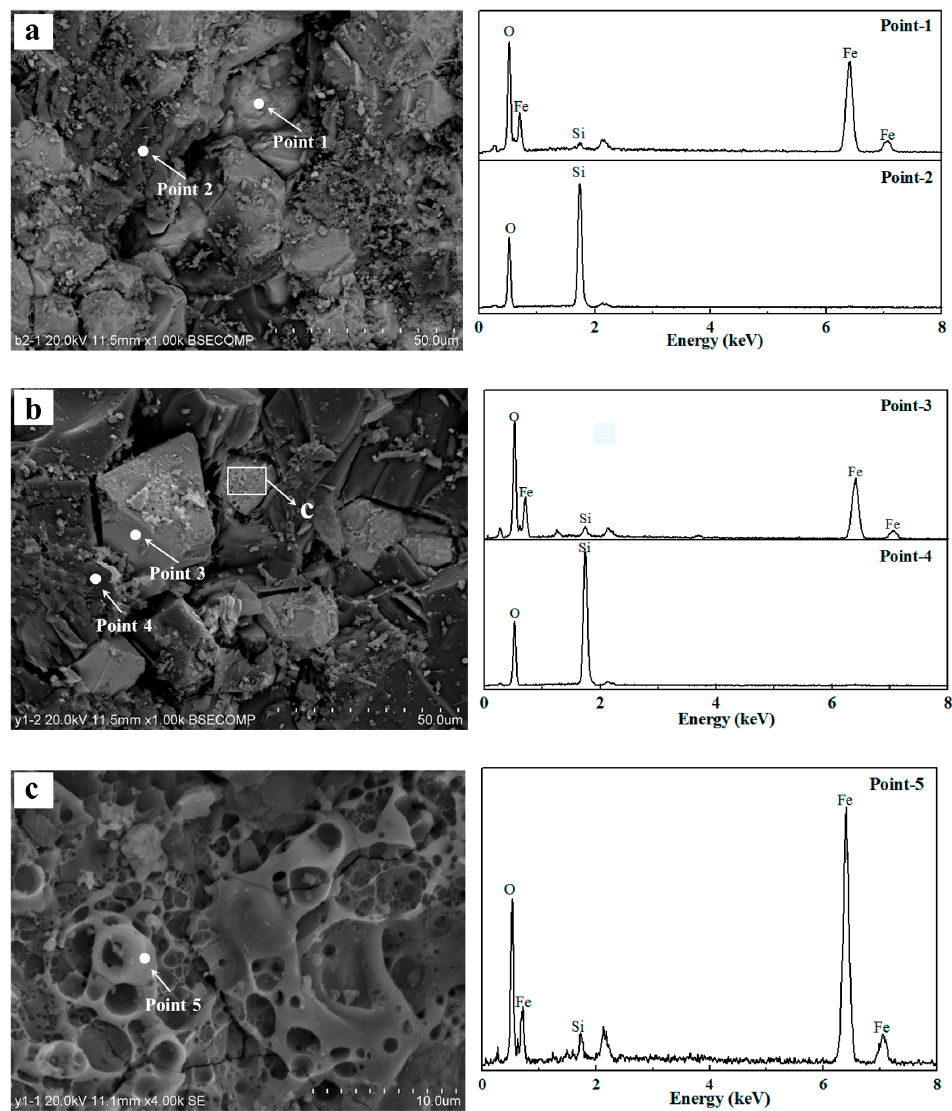
Figure 10. Microstructures of the samples ( a ) untreated and treated ( b – c ) with HVEP pretreatment.